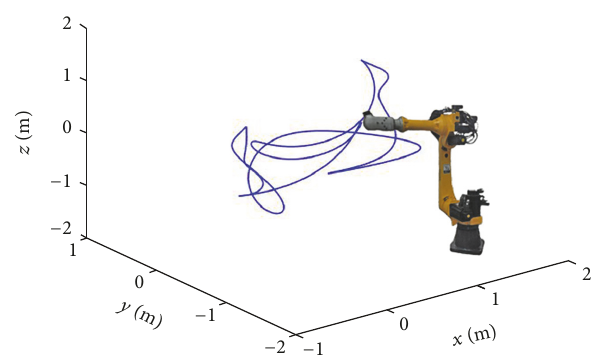
Table 3: Dynamical parameters of